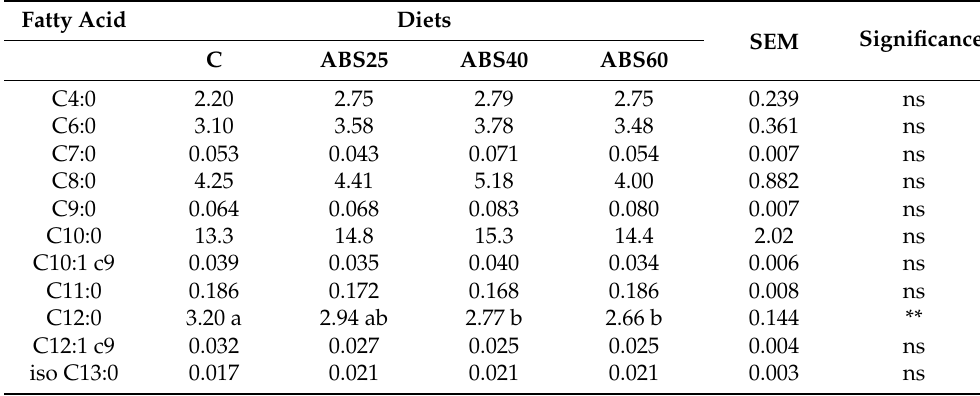
Table 4. Fatty acid composition (g/100 g total fatty acids) measured in milk according to the effects